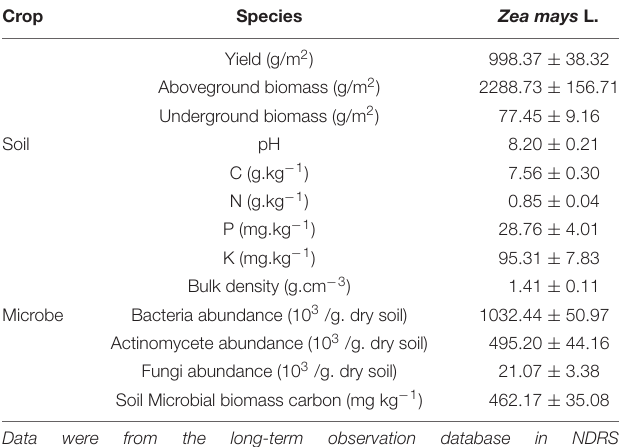
litter powder: 5 g; MgSO 4 · 7H 2 O: 0.8 g; KH 2 PO 4 : 2 g; NaCl: 0.1